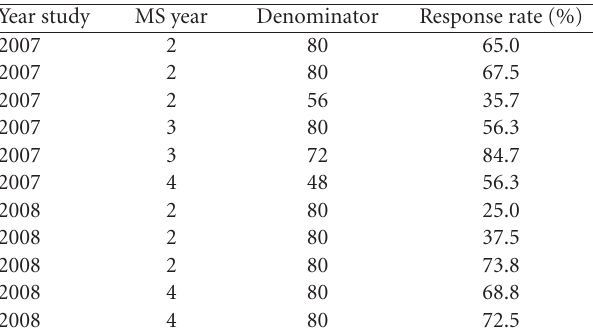
Table 1: Response rate by subject and